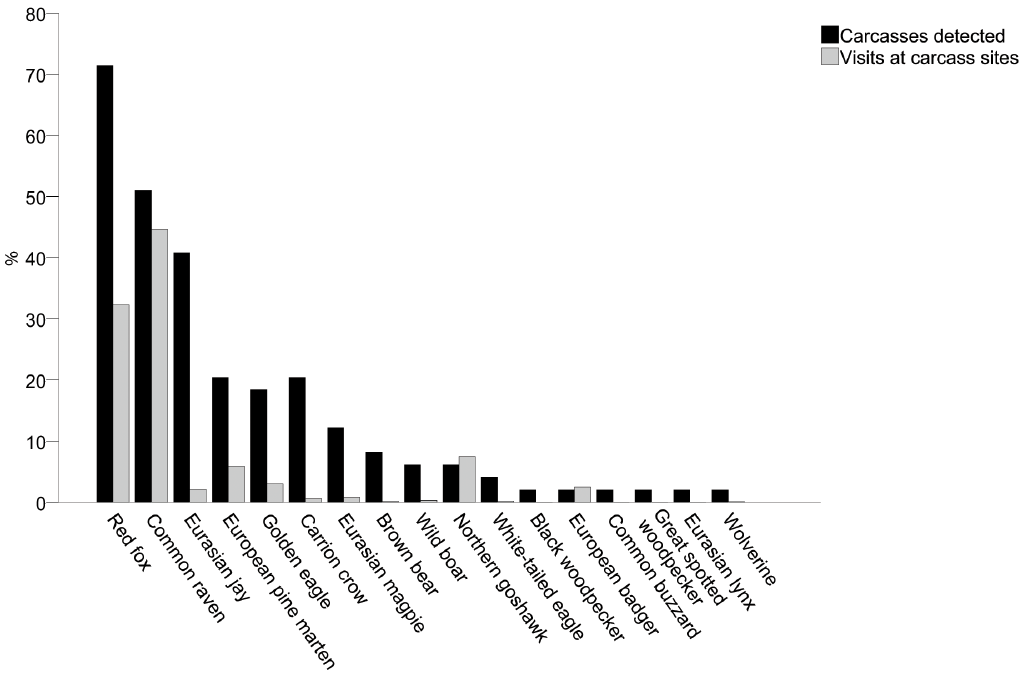
Figure 3. Utilization pattern by scavengers at wolf-killed moose. Proportion of wolf-killed moose (n=49) detected by different scavenging species and proportion of visits to all wolf kills (n=14 783) of respective species. Scavengers were recorded by movement-triggered cameras in Scandinavia.